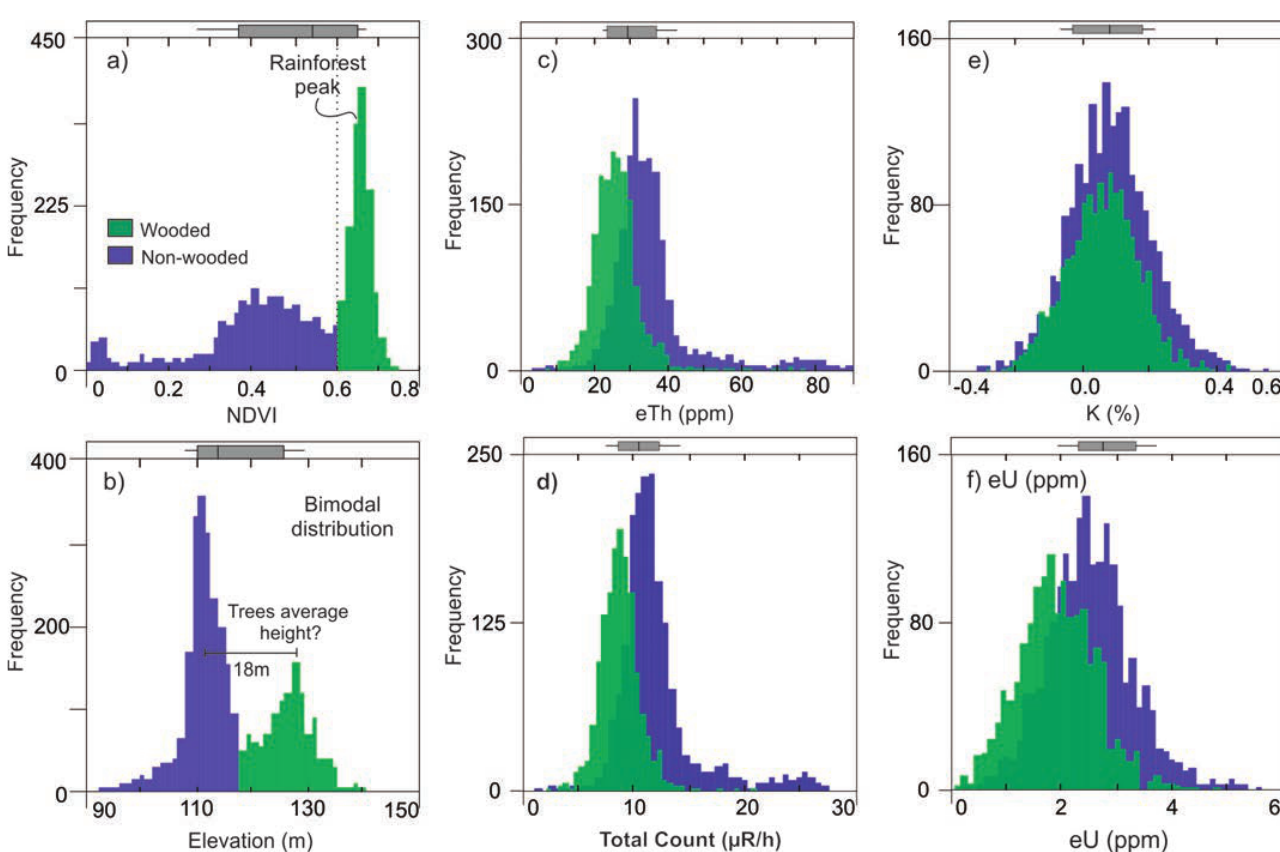
Figure 4 - Set of histograms and data box-plot. a) NDVI histogram showing a 0.7 peak attributed to rainforest, b) Elevation histogram with bimodal distribution. The major peak is around 110 m and the secondary peak is around 130 m. This is attributed to the difference between the average ground level and the average canopy height, c) and d) asymmetric distribution for wooded (green) and non-vegetated (purple) areas for eTh and TC, respectively; e) and f) unimodal symmetric distribution with small range of values for K and eU, respectively Table 1 - Statistic summary of the gamma-spectrometric and elevation data classified by NDVI group and respective linear attenuation coefficient (µ) from the NDVI: 0.00-0.20